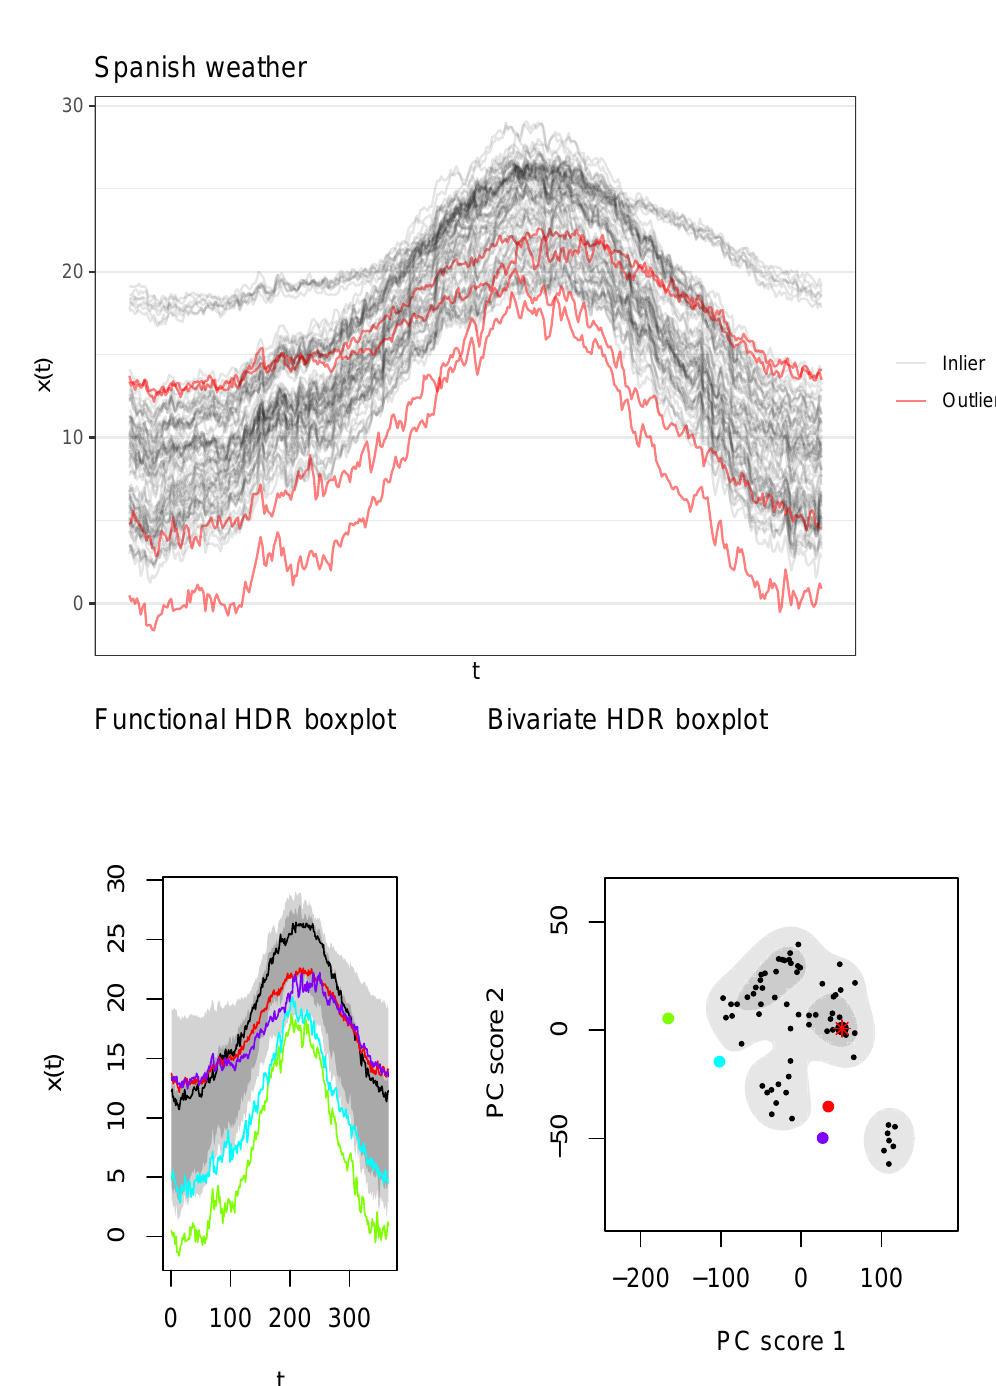
Figure A11. Upper row: Spanish weather data. Lower row, left column: functional HDR box- plot; right column: bivariate HDR boxplot. Colored curves/points are outliers according to a coverage probability of 0.05 for the functional HDR boxplot. HDR boxplots computed with rainbow::fboxplot